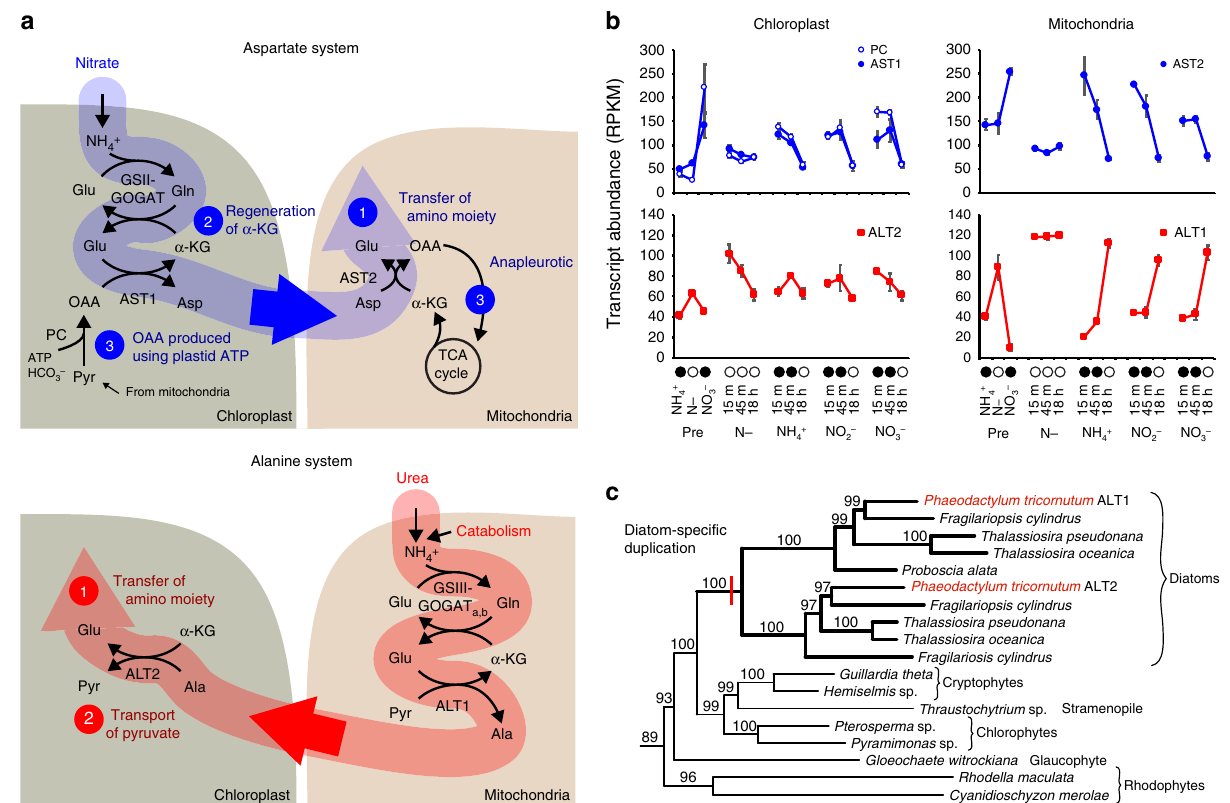
Fig. 8 Aspartate and alanine systems for inter-organellar nitrogen and carbon skeleton transport. a Localization of nitrogen assimilation pathways and con fi guration of aspartate and alanine systems across organelles. Gene name abbreviations can be found in Supplementary Data 3 and fl ux values can be found in Supplementary Data 4. b Transcript-level expression of aspartate and alanine system genes from the N short experiment shown with standard deviation. Closed circles on x axis indicate N-replete time points, open circles show N-deplete time points. c Partial phylogeny of diatom alanine transaminase (ALT) with taxonomic labels. The full tree and ALT sequence accessions can be found in Smith et al. 38 . Source data are provided as a